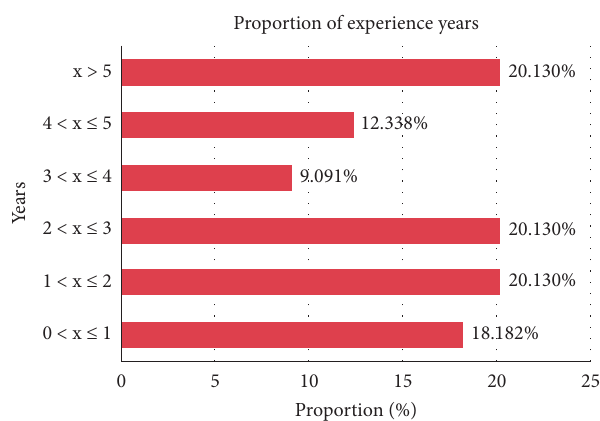
Figure 3: Distribution information of respondents’ experience years. Table 4: Reliability analysis of questionnaires.